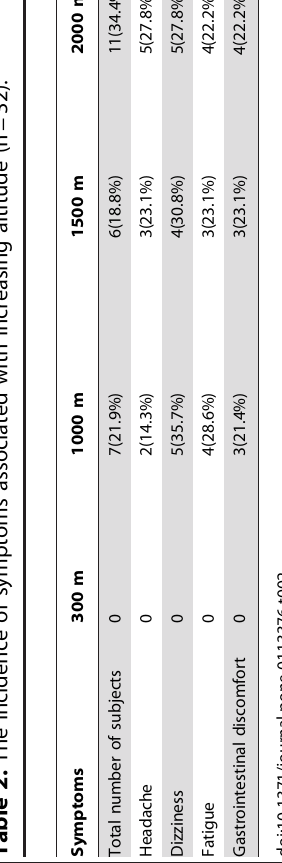
rated the fatigue at 10 mm, and 2 rated it at 20 mm.